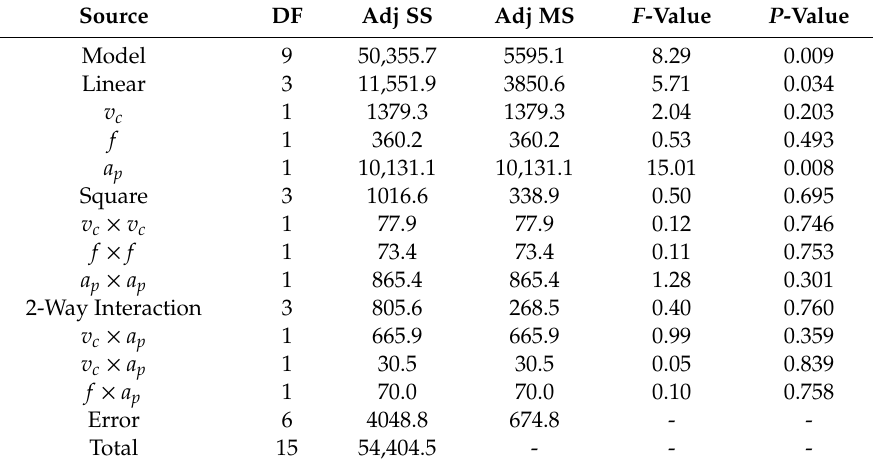
Table 4. Analysis of variance response surface regression: F y versus v c , f , a p